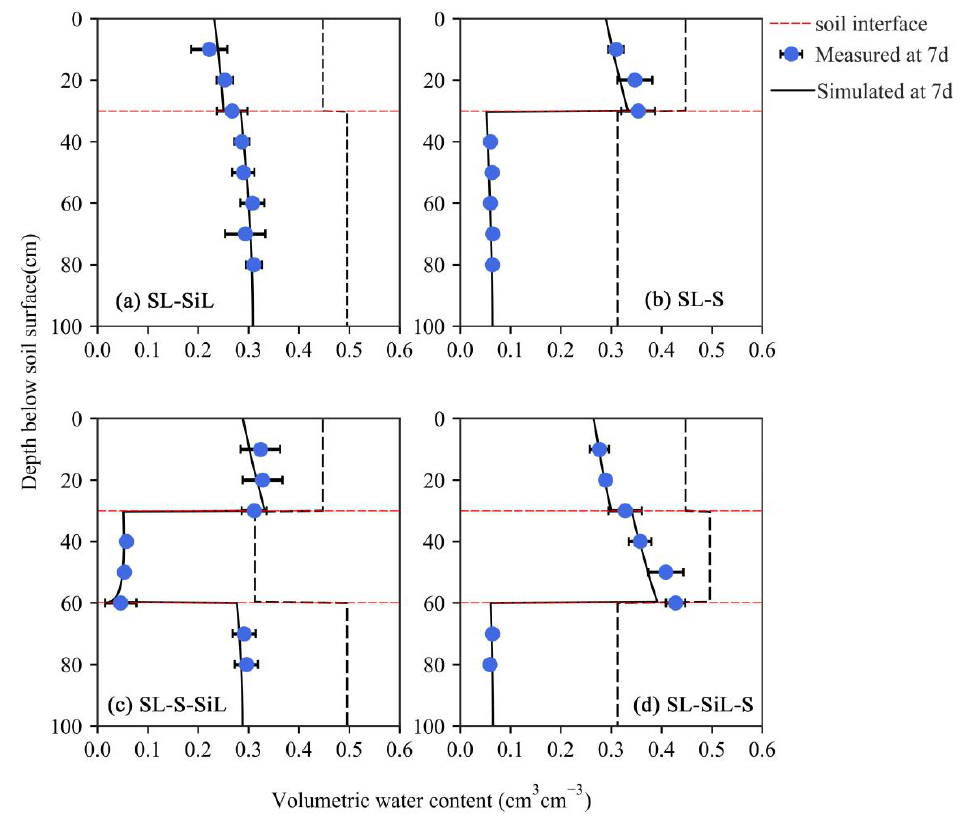
Figure 10. Simulated water content in the drainage process at (a) SL-SiL; (b) SL-S; (c) SL-S-SiL and (d) SL-SiL-S.